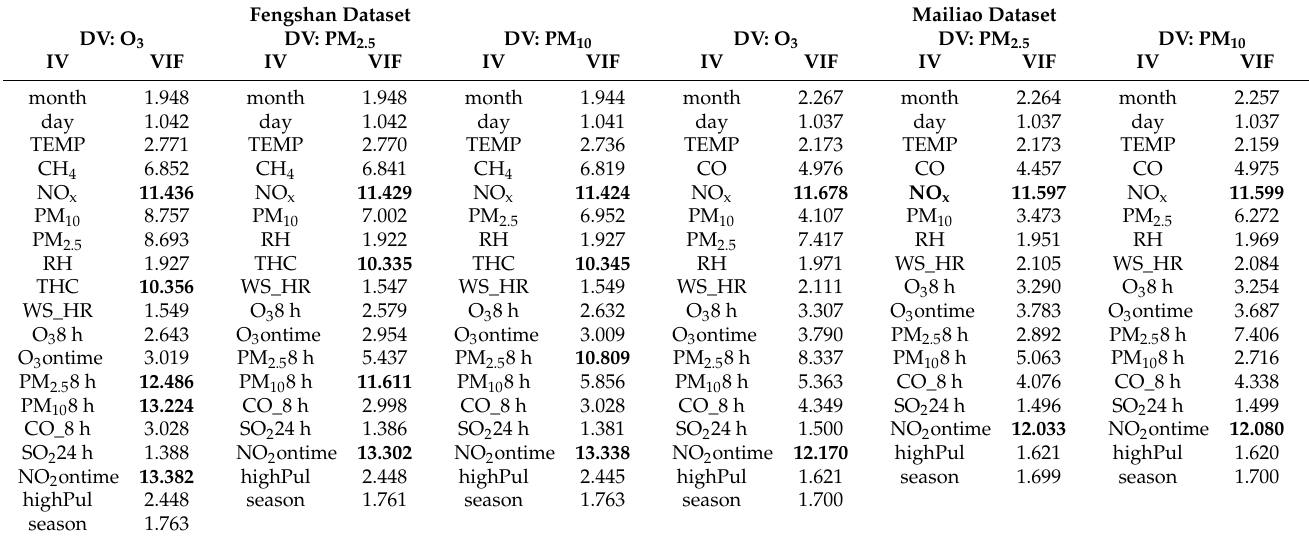
Table 6. Collinearity tests of O 3 , PM 2.5 , and PM 10 regression models for two datasets. Fengshan